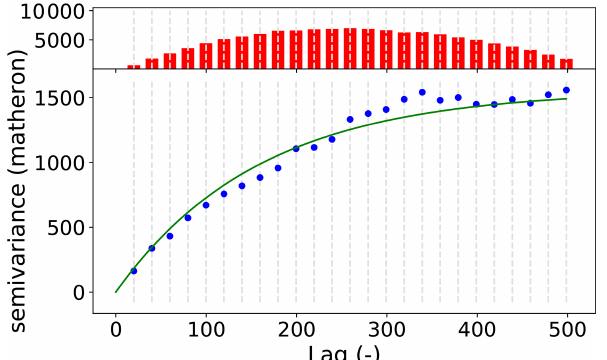
Figure 2. Default variogram plot of SciKit-GStat using the mat- plotlib back end. The variogram was estimated with the pancake dataset using the exponential model (green line) fitted to an ex- perimental variogram (blue dots) resolved to 25 evenly spaced lag classes, up to 500 units (the axis length of the sampled field). The histogram in the upper subplot shows the number of point pairs for each lag class. The histogram shares the x axis with the variogram to identify the corresponding lag classes with